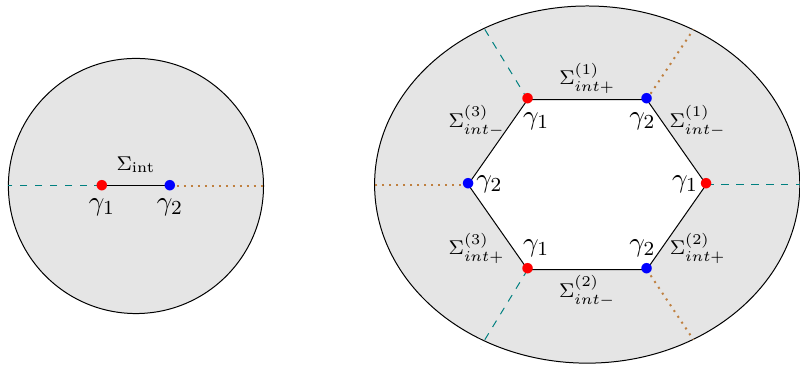
Figure 3 . Left: a two-dimensional projection of an n = 1 solution with two extremal surfaces γ 1 , γ 2 (having areas A 1 and A 2 ) and a surface Σ int stretching between them. Right: an n -fold cover of the figure at left for the case n = 3 after cutting open a slit along Σ int . The 2 n copies of Σ int are labeled Σ ( i ) , where i = 1 , . . . , n . Saddles for the Rényi entropy are formed by identifying Σ ( i ) int ± with Σ ( π ( i )) for some permutation π . After making such identifications, the number N 2 = n − n 2 int − of copies of γ 2 that remain is the number C ( π ) of cycles generated by π , while the corresponding N 1 = n − n 1 is C ( τ ◦ π ) where τ is the counterclockwise cyclic permutation. The asymmetry is due to the numbering of replicas, which breaks the natural symmetry between the dashed lines (separating replicas) and dotted lines (separating the two halves of each